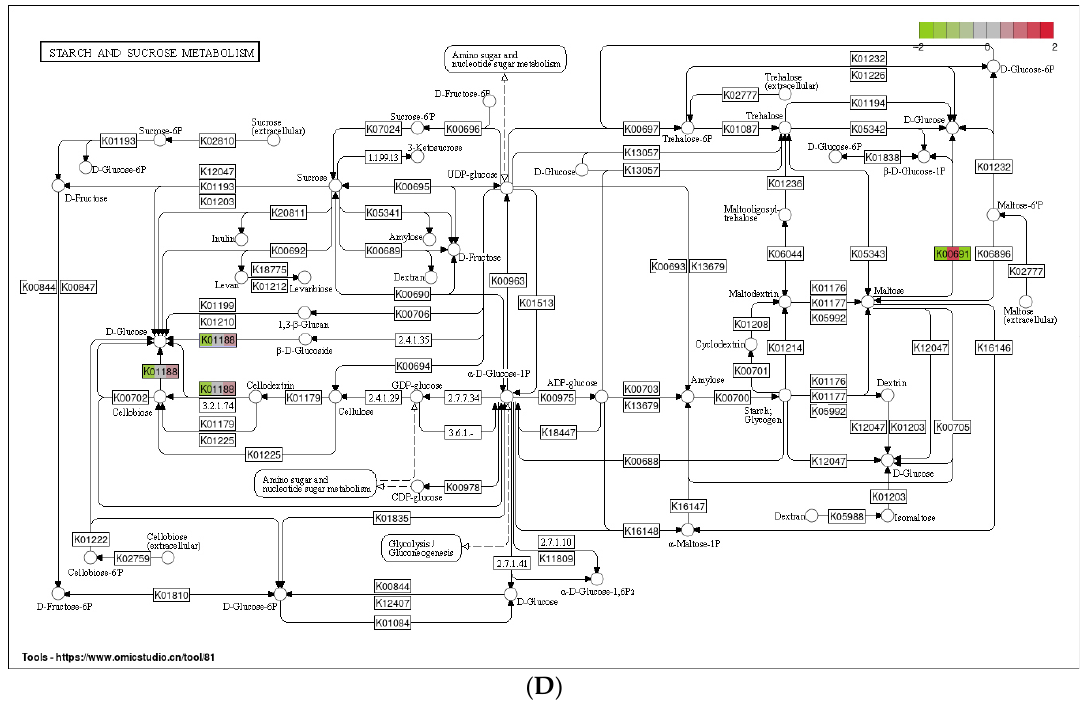
Figure 4. Functional and pathway annotation comparison of the genes assigned to the KEGG database. ( A ) Function annotation at KEGG level 1. ( B ) Function annotation at KEGG level 2. ( C ) Gene abundance comparison in the fructose and mannose metabolism pathway. ( D ) Gene abundance comparison in the starch and sucrose metabolism pathway. Notes for C and D: The genes belonging to the three samples with significant differences in the metabolic pathway map are marked by a color, in which Mec, Oce, and Gry are from left to right. The red to green color represents the high to low gene abundance. (https://www.omicstudio.cn/tool, accessed on 22 May 2022)